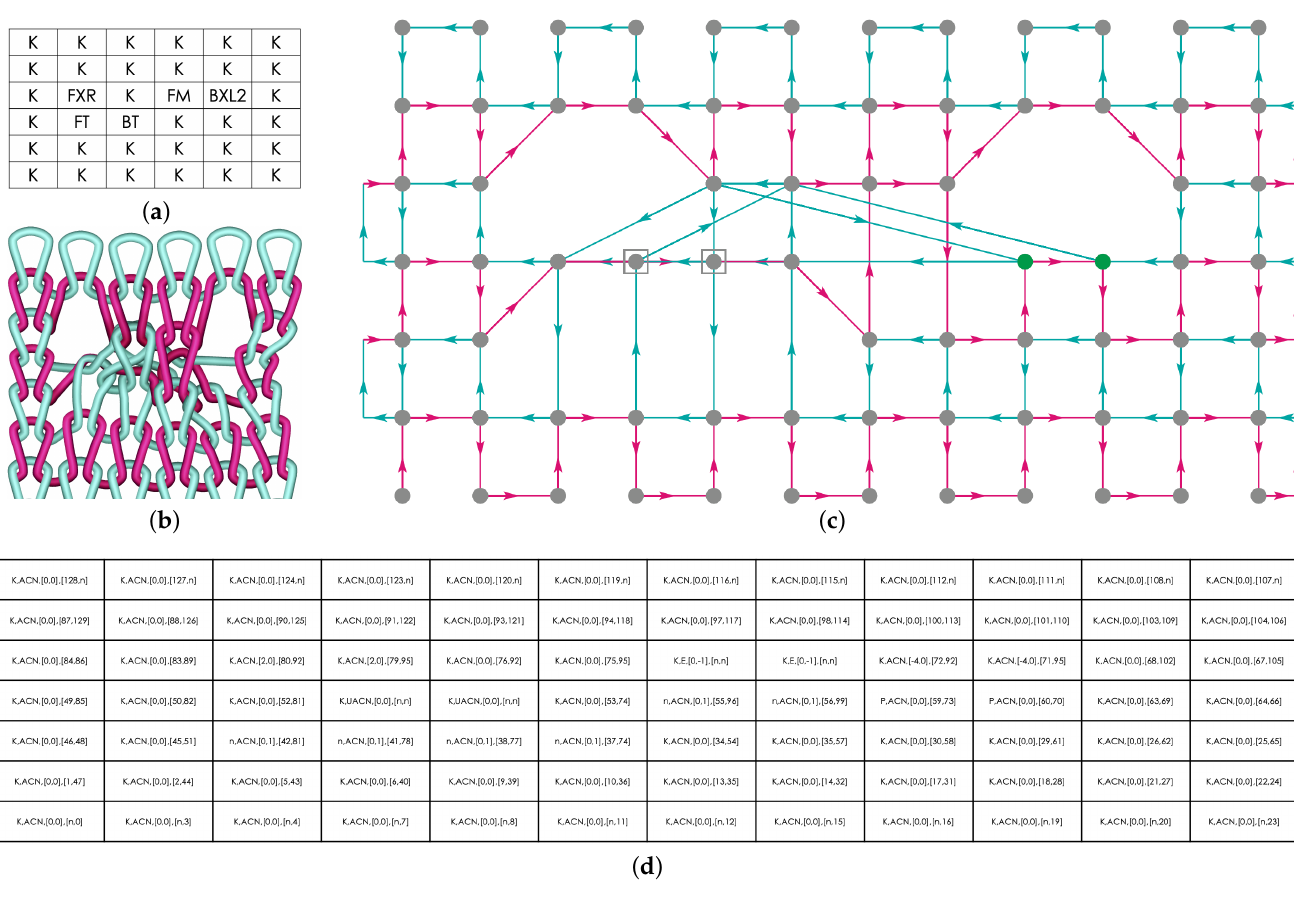
Figure 10. Stitch pattern with a combination of Knit, Front Transfer, Back Transfer, Front Miss, Front Tuck, and Back Tuck stitches. ( a ) Stitch instructions. ( b ) Simulation of stitch pattern. ( c ) Topology graph. ( d ) Corresponding data structure after